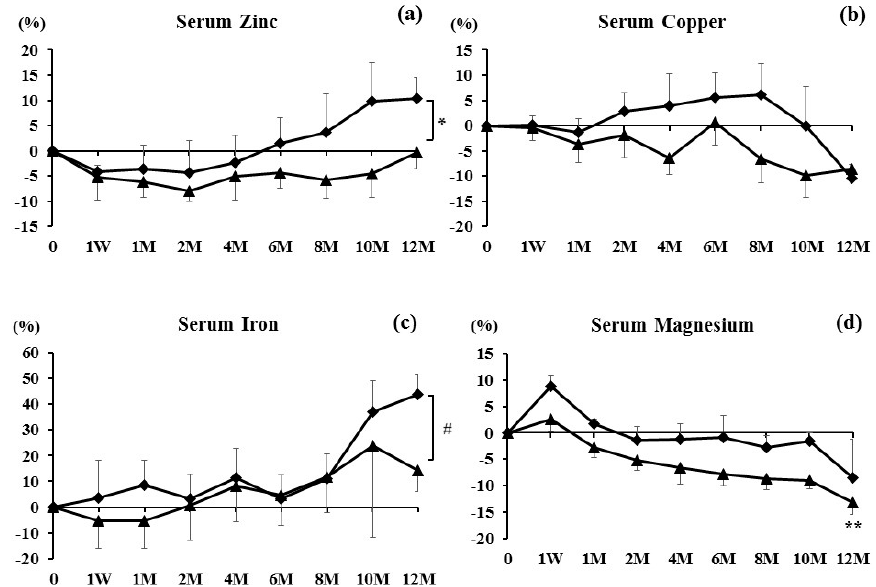
Figure 2. Percent changes in ( a ) Serum Zinc, ( b ) Serum Copper, ( c ) Serum Iron, and ( d ) Serum Magnesium were examined at one week and 1, 2, 4, 6, 8, 10, and 12 months after denosumab treatment. Results are expressed as the mean ± SE. Diamond shapes indicate the bisphosphonate (BP) group and triangles indicate the teriparatide (PTH) group. * p < 0.05 and p < 0.1, significant tendency between the